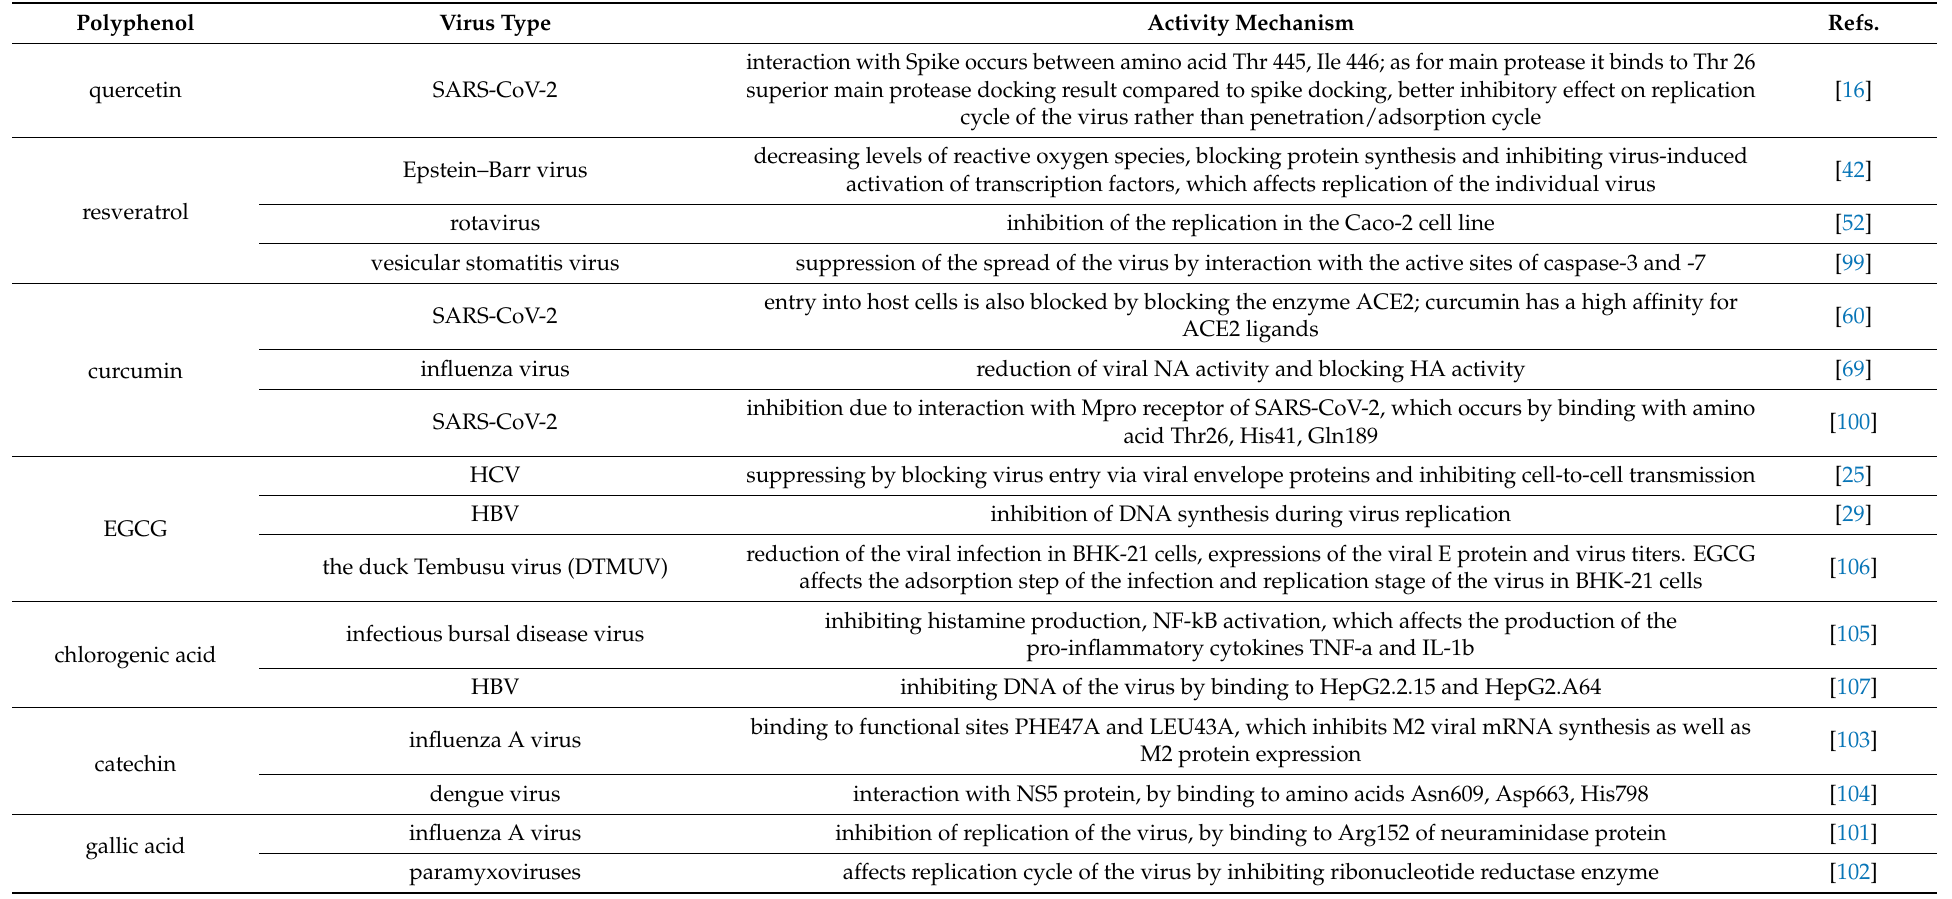
Table 2. Antiviral activity mechanism of individual polyphenols mostly found in